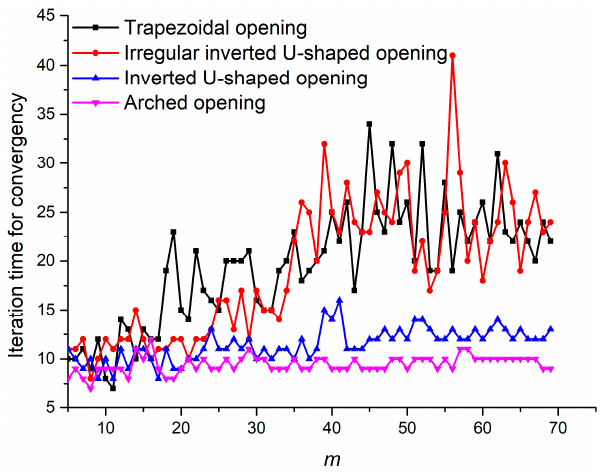
Figure 6. The relation curves between iteration time and m.